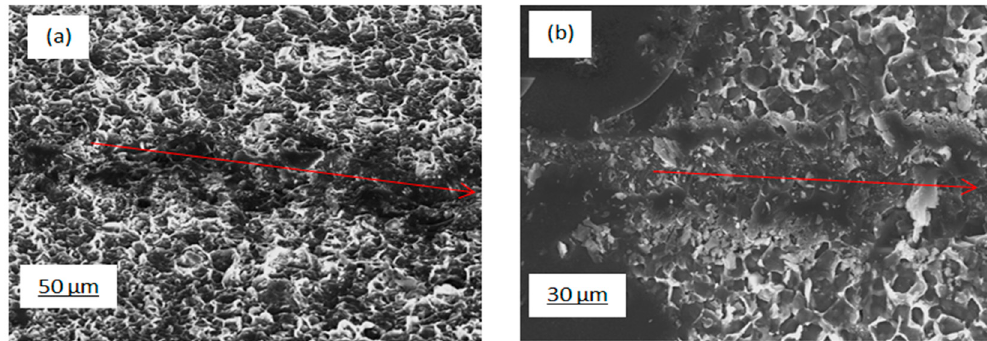
Figure 9. SEM images of the as-etched silicon nanoflakes: ( a ) scratch path through silicon nanoflakes at low magnification and ( b ) scratch path silicon nanoflakes at high magnification (red arrow showing scratch path).